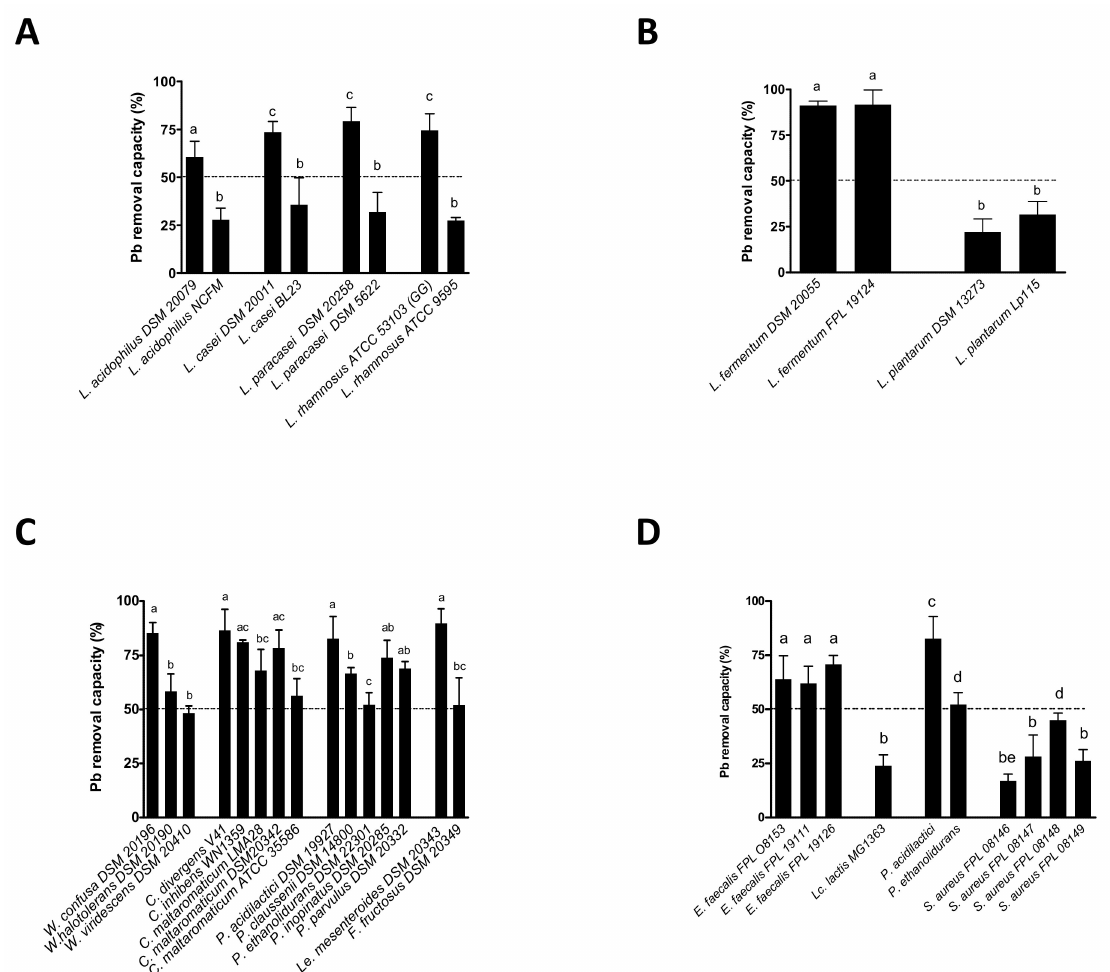
Figure 2. The Pb(II) removal capacity of distinct strains of LAB. Panel ( A ): Five selected pairs of strains from the same species but with distinct removal capacities. Panel ( B ): Two selected pairs of strains from the same species but with similar removal capacities. Panel ( C ): Four selected groups of strains from the same genus but with distinct removal capacities. Panel ( D ): Four selected strains from groups of cocci with distinct removal capacities. Metal removal capacity was defined as the mean ± SD percentage of the initial quantity of metal in solution, in triplicate experiments. Different letters indicate significant ( p < 0.05) between-strain